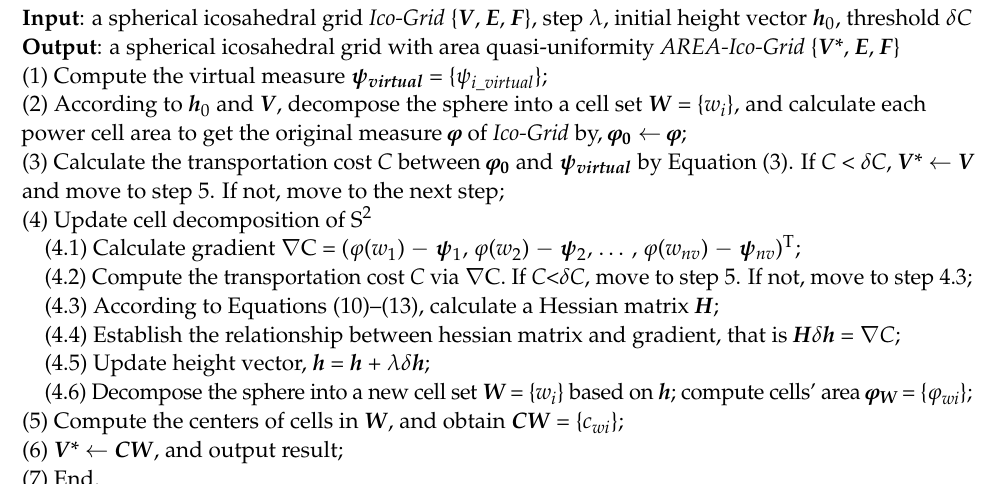
Algorithm 1 : Area Uniformity Optimization for the Spherical Icosahedral Grid